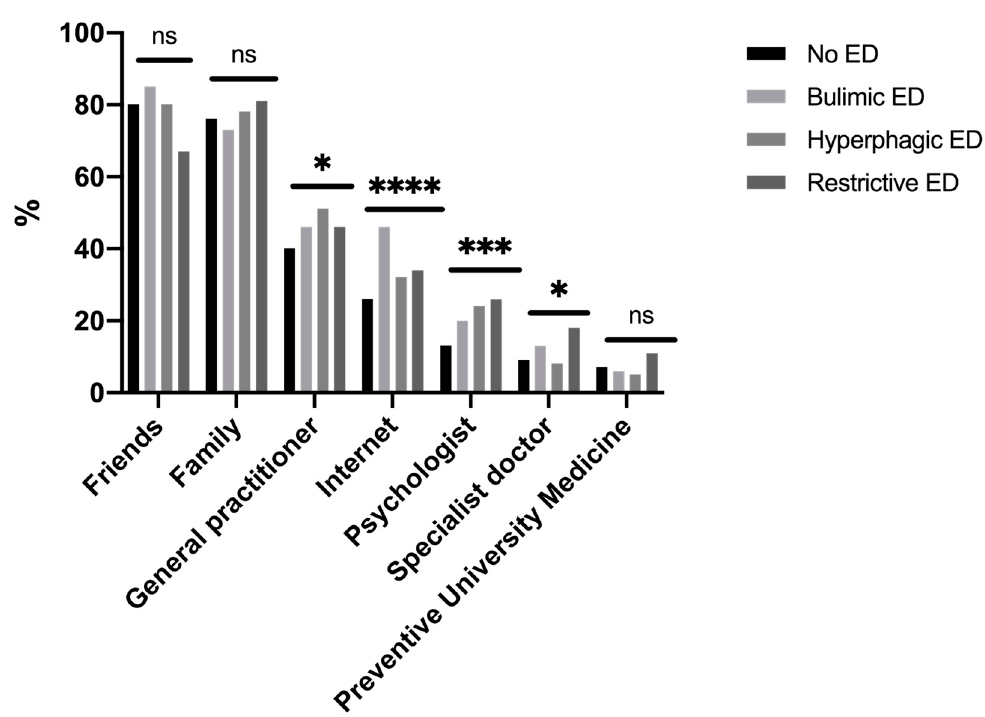
Figure 3. Categories of help-seeking in cases of emotional problems with anxiety and stress ( n = 1493). ns: non significant. *: p < 0.05. **: p < 0.01. ***: p < 0.001. ****: p < 0.0001.